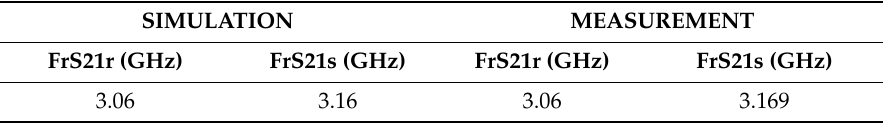
Table 2. The di ff erence between simulation and measurement.